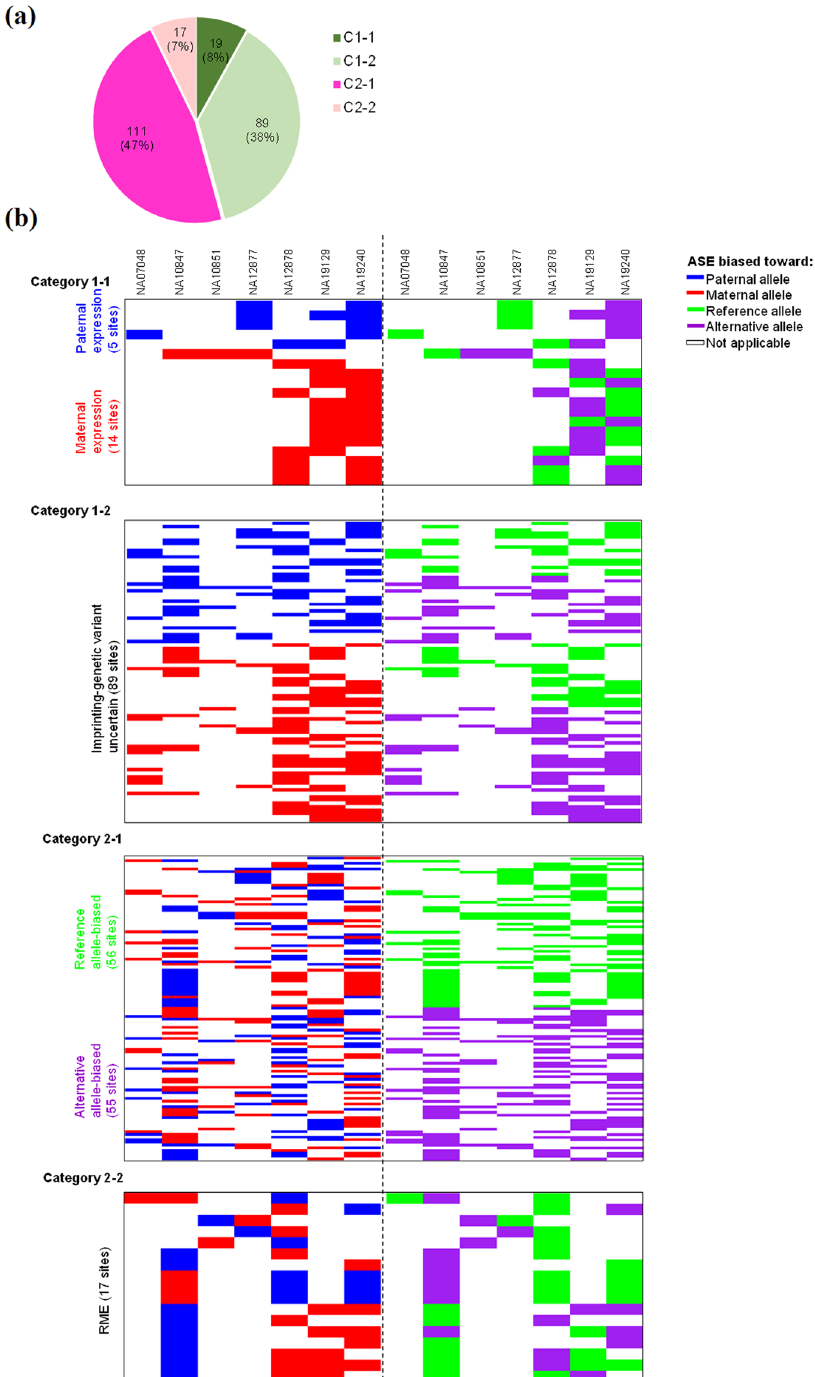
Figure 2. The four categories of ASE sites. ( a ) Distribution of the four categories. ( b ) The heatmap representing the distinct patterns for the four categories of ASE sites across the applicable individuals (see also Dataset 1 for further